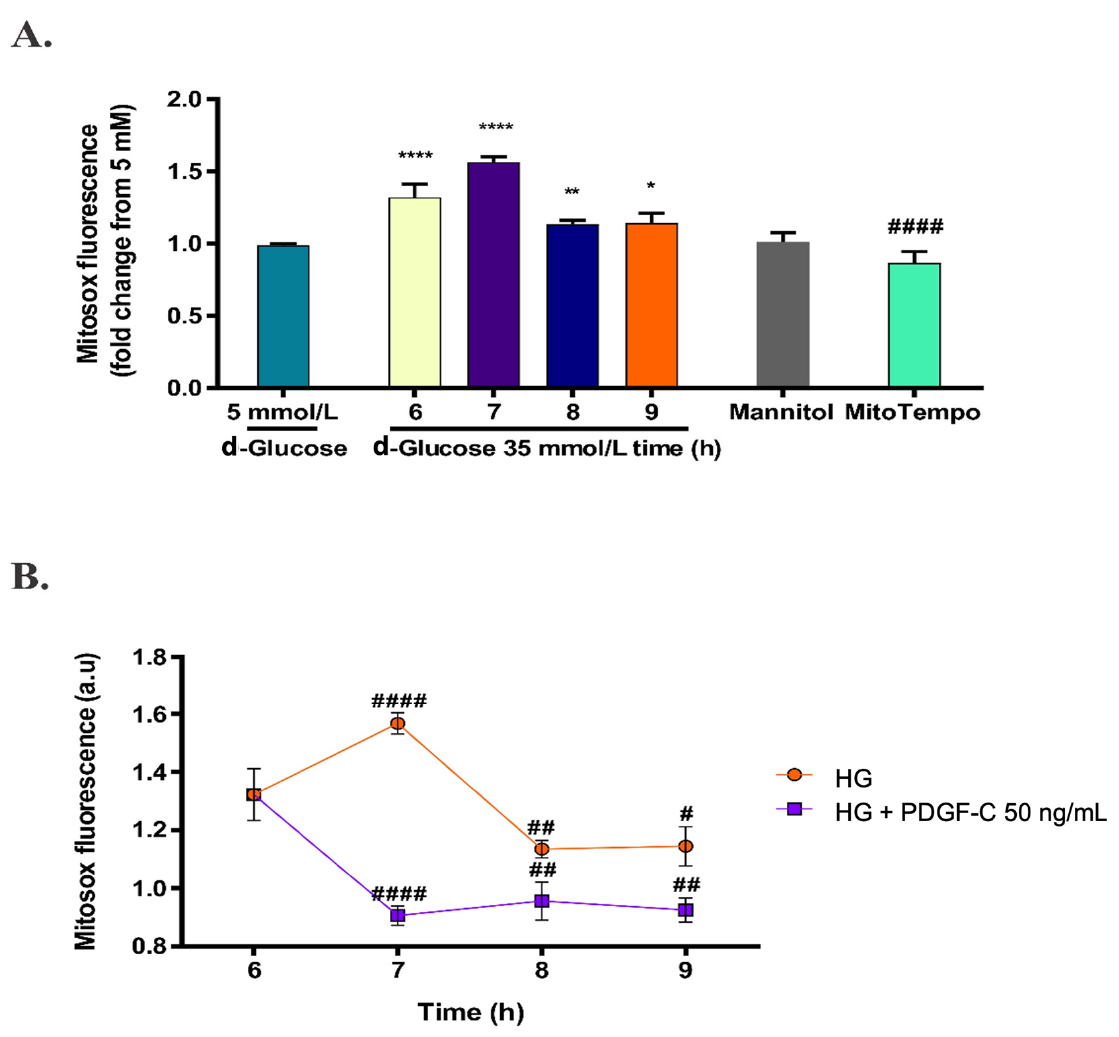
Figure 3. Effect of PDGF-C on mitochondrial ROS production induced by high d-glucose. HAECs were seeded in 96-well plates and exposed to 35 mmol/L d-glucose for 6 to 9 h, without ( A ) and with ( B ) 50 ng/mL PDGF-C. Mitochondrial ROS production was measured each hour by fluorometry with MitoSOX TM . A total of 10 µ mol/L MitoTEMPO for 1 h before HG treatment and 30 mmol/L mannitol were used as antioxidant and osmolarity controls, respectively. Data with * are presented as change in the mean of fluorescence regarding 5 mmol/L d-glucose ± SEM of at least three inde- pendent experiments (**** p < 0.0001, ** p < 0.001, * p < 0.05). Data with # are presented as change in mean of fluorescence regarding 35 mmol/L d-glucose for 6 h ± SEM of at least three independent experiments (#### p < 0.0001, ## p <0.01, # p < 0.05).